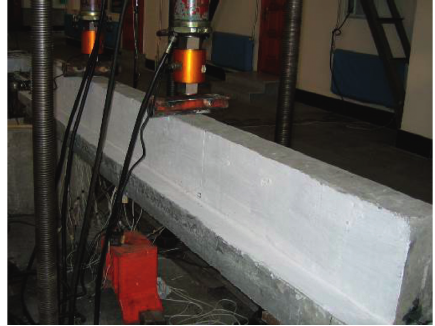
Figure 10: Single-span composite T-shaped beam. Table 5: Details of single-span beams.